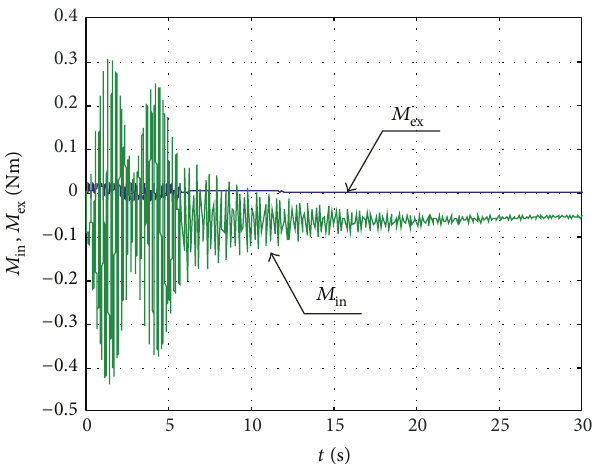
Figure 13: Time-dependent control moments 𝑀 optimum parameters of the regulator without the influence of disturbances.